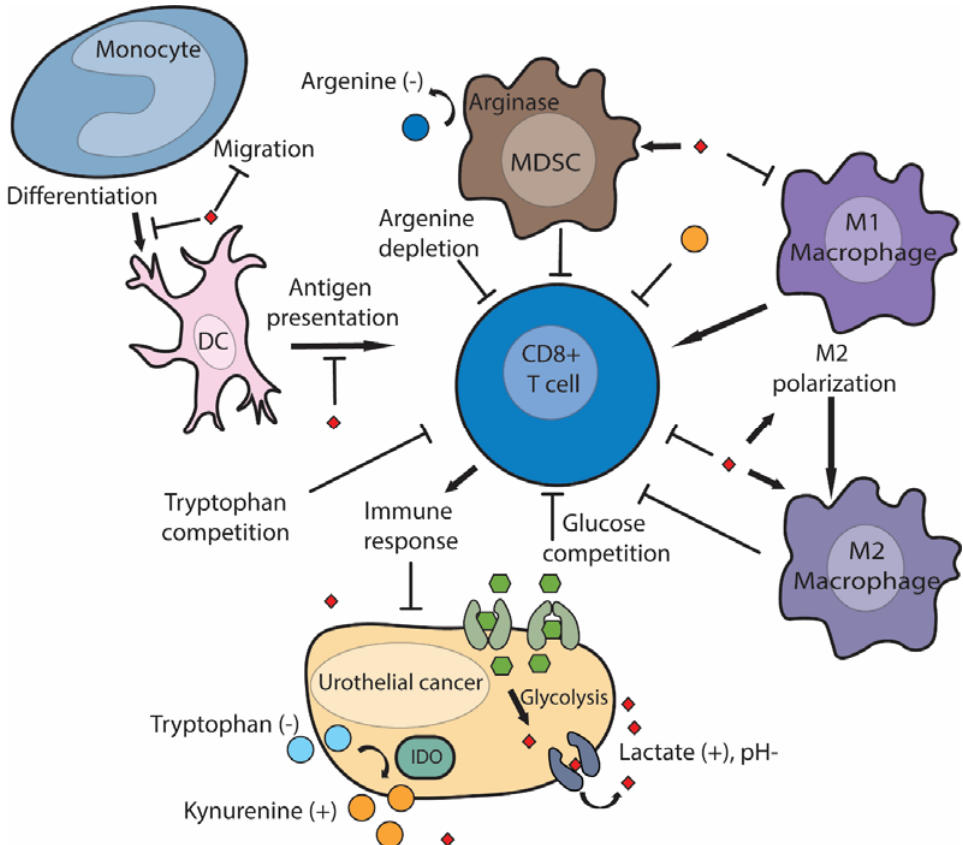
Figure 2. How urothelial cancer metabolism impacts immune cells in tumor microenvironment (TME) . Urothelial cancer creates an acidic TME deprived of glucose, tryptophan, and arginine, whereas concentrations of immune-suppressive molecules, such as lactate and kynurenine, are increased. Excessive lactate in the TME inhibits the tumor immune response by (1) polarization of macrophages to a suppressive M2 phenotype, (2) inhibition of monocyte migration and differentiation into dendritic cells (DC), thereby inhibiting antigen presentation and subsequent T cell activation, (3) by stimulating immune-suppressive myeloid-derived progenitor cells (MDSCs) to breakdown immune-stimulatory arginine, or (4) through direct inhibition of CD8+ T cell function by lactate. The T-cell-mediated immune response is also directly inhibited by tumor-produced kynurenine and indirectly through tumor-induced tryptophan and glucose shortage.